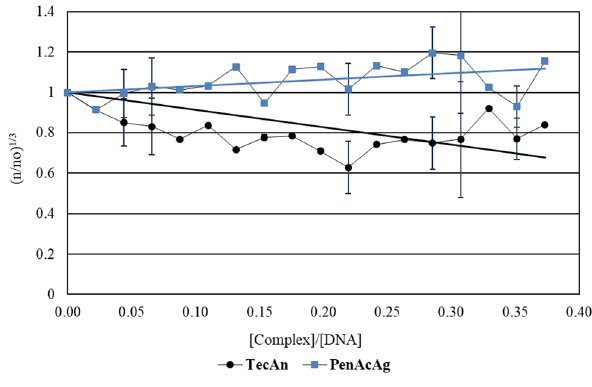
Figure 11: E ff ect of increasing concentrations of TecAn and PenAcAg on the relative viscosity of CT - DNA at 25°C. ([ DNA ] = 10 mM, r = [ compound ] / [ DNA ] , n is the viscosity of DNA in the presence of TecAn and PenAcAg and n o is the viscosity of DNA alone )